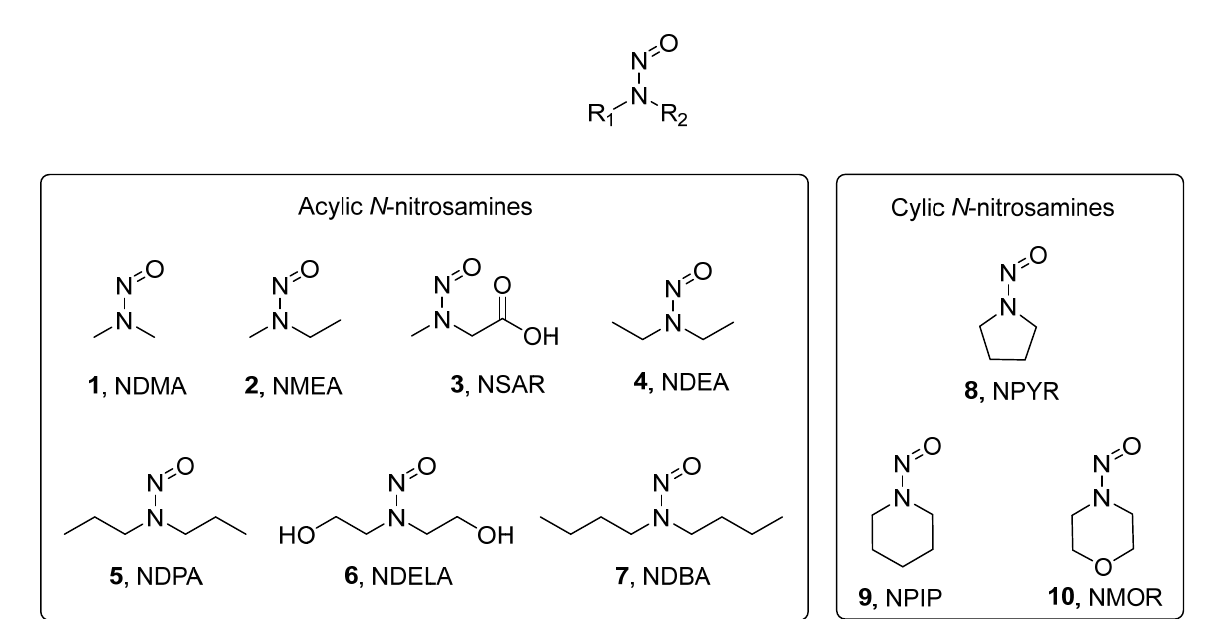
Figure 1. Chemical structures of carcinogenic N -nitrosamines to which humans are commonly exposed. NDMA, N -nitrosodimethylamine; NMEA, N -nitrosomethylethylamine; NSAR, N -nitrososarcosine; NDEA, N -nitrosodiethylamine; NDPA, N -nitrosodi- n -propylamine; NDELA, N -nitrosodiethanolamine; NDBA, N -nitrosodi- n -butylamine; NPYR, N -nitrosopyrrolidine; NPIP, N -nitrosopiperidine; NMOR, N -nitrosomorpholine.